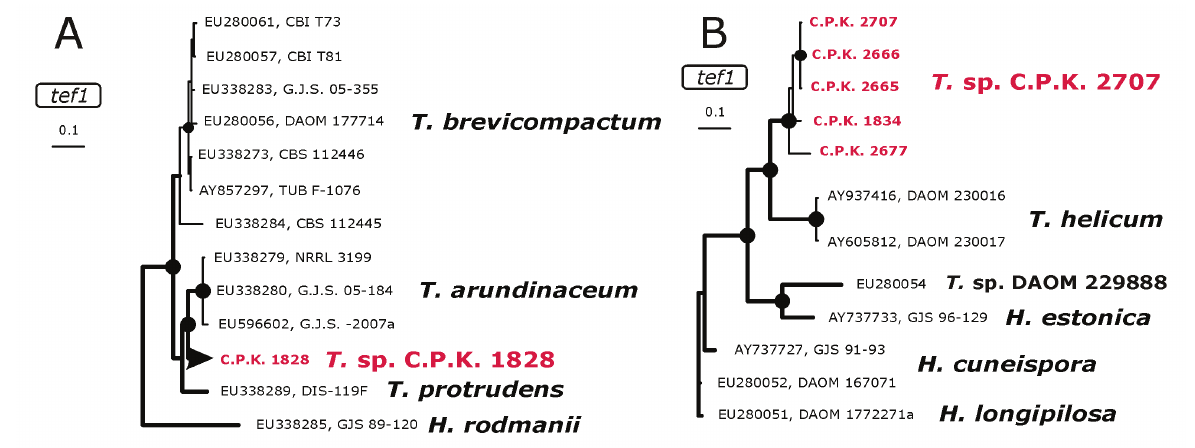
Figure 4. Identification phylogram of a potentially new species within the Brevicompactum clade (a) and a potentially new species related to T . helicum (b) based on the Bayesian analysis of tef1 intron. Nodes marked by black circles indicate posterior probabilities > 0.94. All reference strains are given by the accession number of the corresponding tef1 sequence in GenBank and strain